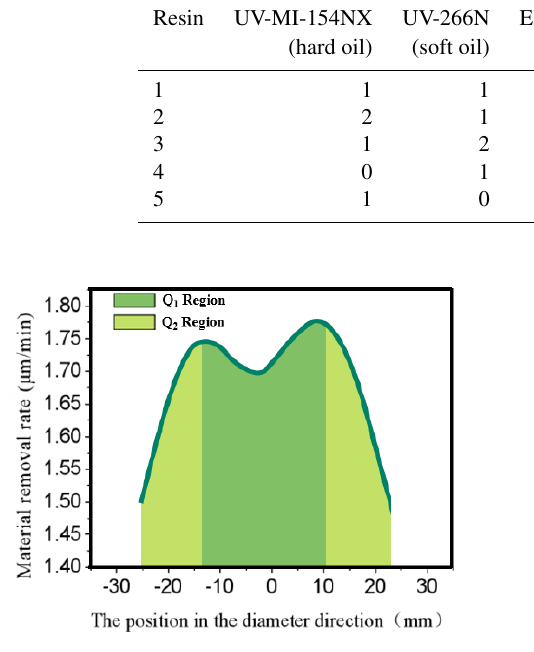
Figure 7. A 2D diagram of the material removal rate (MRR).